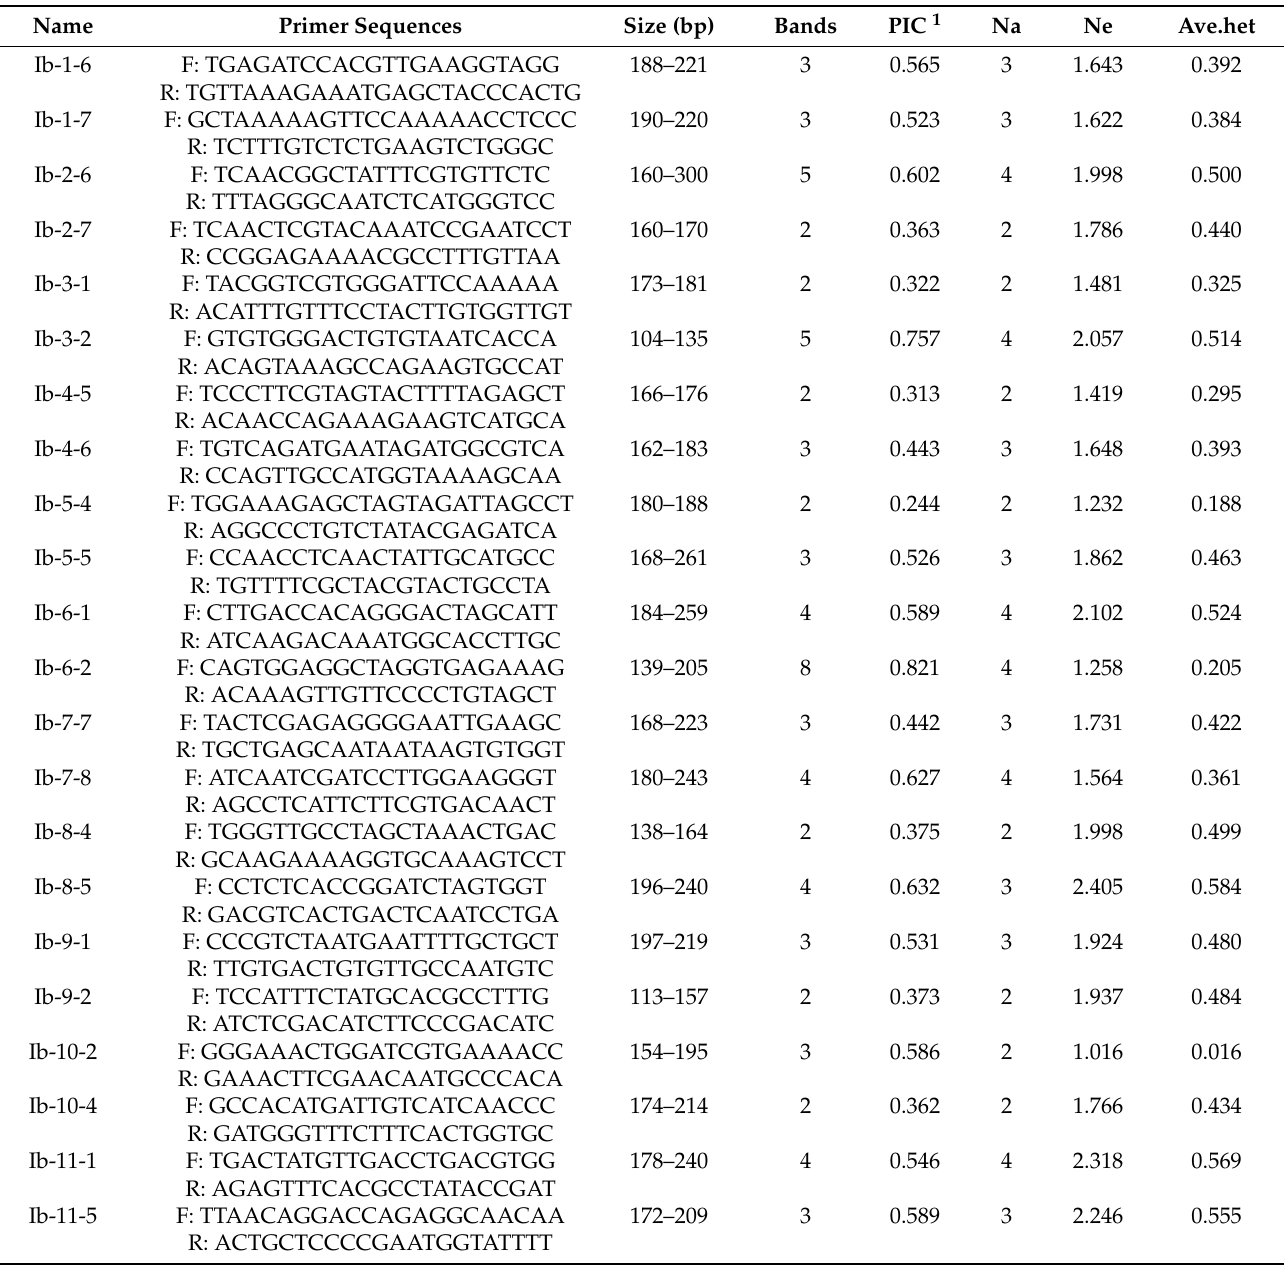
Table 1. The information on the 30 InDel markers used in this